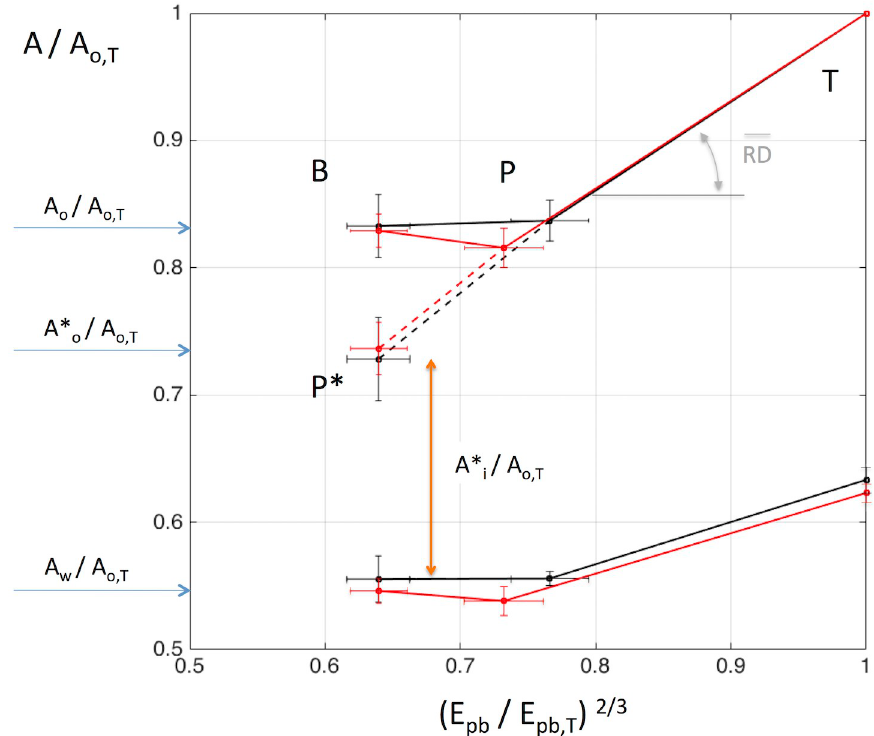
Fig 5. Effects of broncho-provocation with MCh (B to P) and inhalation to TLC (P to T), on average airway cross- sectional outer area ( A ), vs the corresponding averages of peribronchial parenchymal expansions, E . Plots o pb present the relationship between, A O normalized by the equivalent area at TLC ( A o , T ) and E pb normalized by E pb at ) elevated to the 2/3 power, at baseline ( B ), post MCh ( P ) and TLC ( T ) of all segmental airways for all subjects TLC ( E pb , T with asthma (AS in in black) and those without asthma (NA in red). The data are presented as mean +/- SEM. The slope of the relationship between P and T corresponds to the relative distensibility ( RD ) of the average airway. A � o corresponds to the value of the airway outer area, A , as estimated by extrapolation assuming constant RD, that would o have been expected had there been no change peribronchial expansion, E pb , following bronchoconstriction. Also normalized by A ( A ) for the three states B,P and T, and the shown are the values of airway wall area A w o , T w /A o , T difference between A o � /A o,T and A w /A o , T corresponds to the average luminal area had peribronchial lung expansion remained the same as at baseline (A i � /A o,T